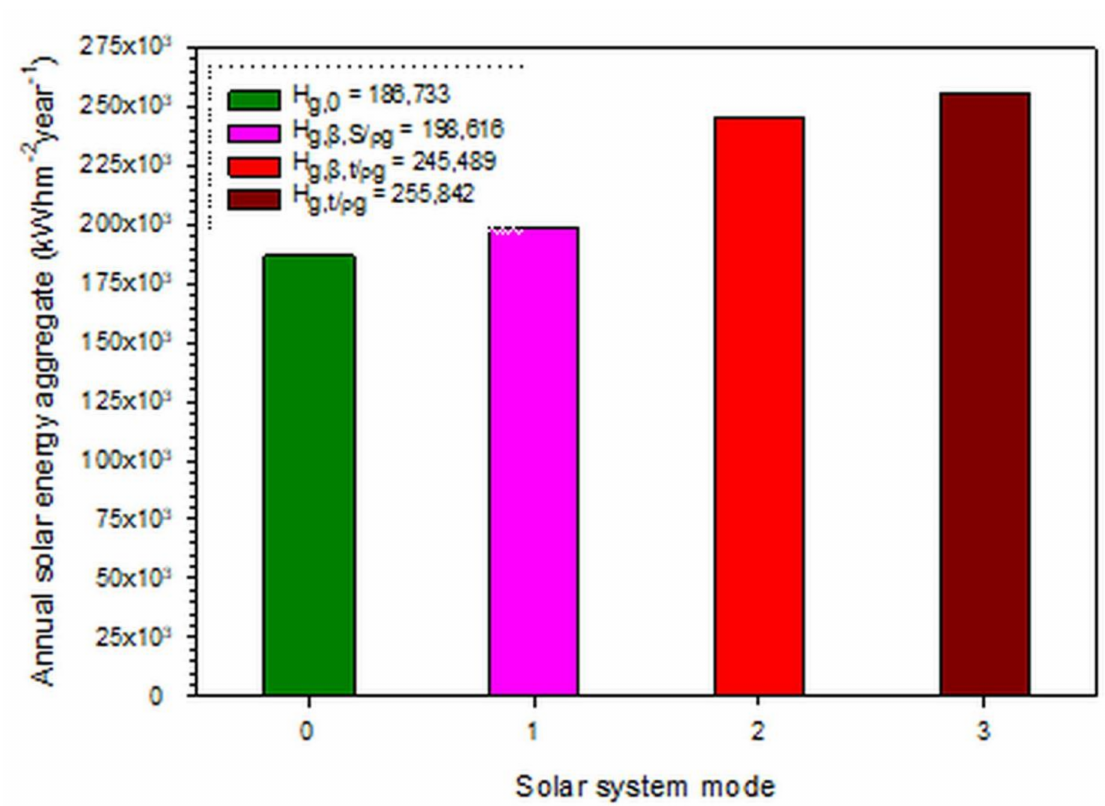
Figure 4. Annual solar energy aggregate (sum, yield) across all 82 sites in Saudi Arabia for each type of installation; 0: horizontal surface; 1: mode (i) static system; 2: mode (ii) dynamic system; 3: mode (iii) dynamic